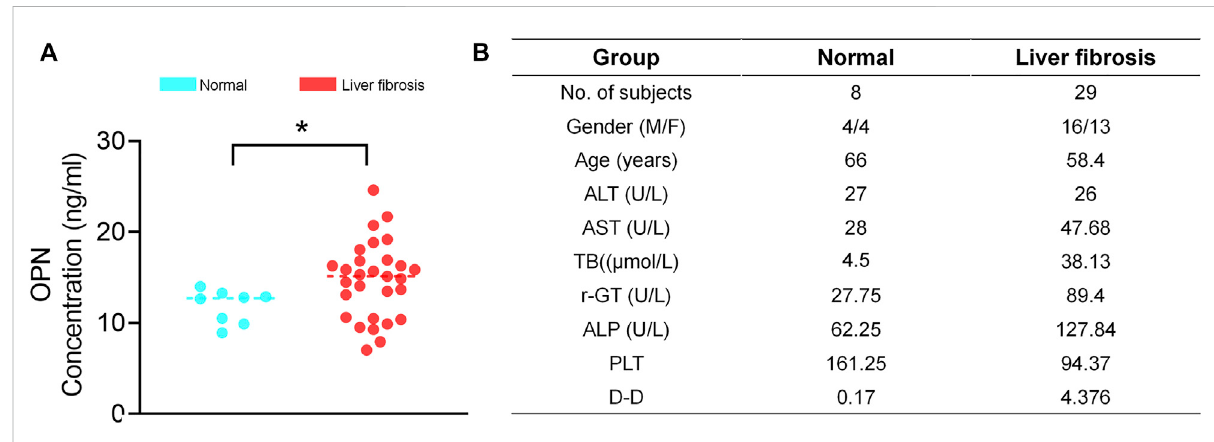
FIGURE 7 Serum OPN upregulated in liver fi brosis patients. (A) The serum was collected from patients with liver fi brosis and healthy people and centrifuged. The OPN concentration was measured by ELISA. (B) Clinical pro fi les of healthy people and patients with liver fi brosis enrolledfor serum OPN analysis. The data are expressed as unpaired two – tailed Student ’ s t – test. P < 0.05